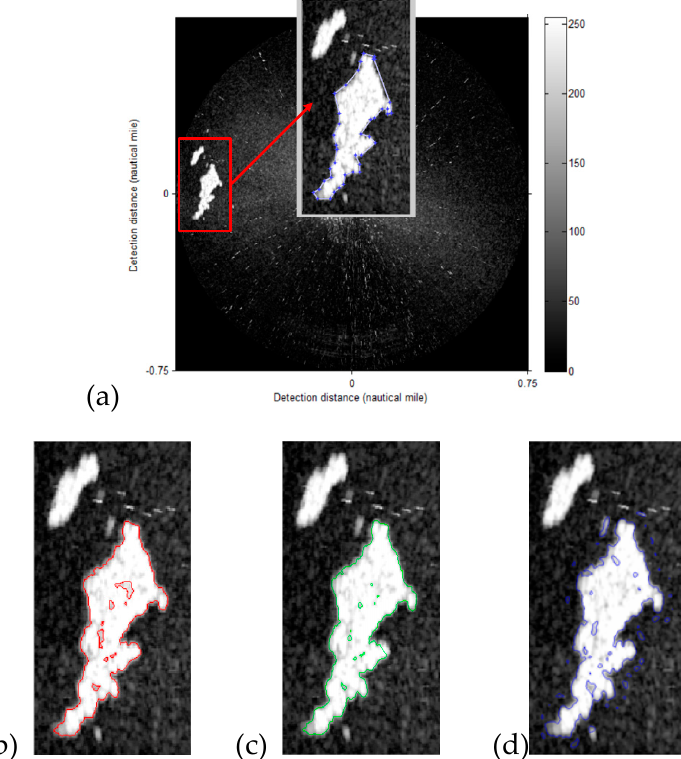
Figure 12. Coastline segmentation results of a ship-borne radar image (collected at 08:59:20, 12 August 2015). ( a ) Initial contour; and ( b – d ) results from the LBF, LGIF, and LIF models, respectively. Parameters: λ = 1, λ = 2, σ = 5, and i (number of iterations) = 5. 1 2